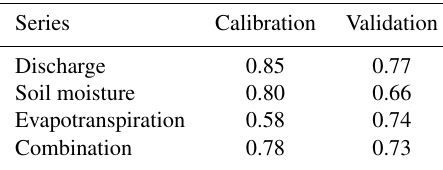
Table A4. Catchment-scale performance measures (discharge – Nash–Sutcliffe efficiency at the Useldange gauge; soil moisture and evap- otranspiration – Nash–Sutcliffe efficiency of catchment averages) of the SHM Attert in the 5-year calibration period (1 November 2011 in CET. The term “combination” refers to the joint objective function according to Eq. (A12).